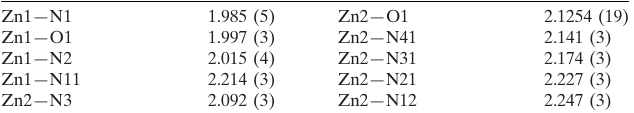
Selected bond lengths (A ˚